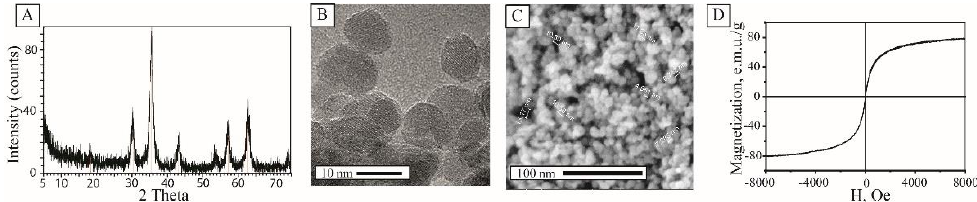
Figure 2. XRD pattern of the synthesized magnetite nanoparticles (MNPs) ( A ); TEM image of the particles ( B ); SEM image of the MNPs ( C ); magnetization curve of the material ( D ).